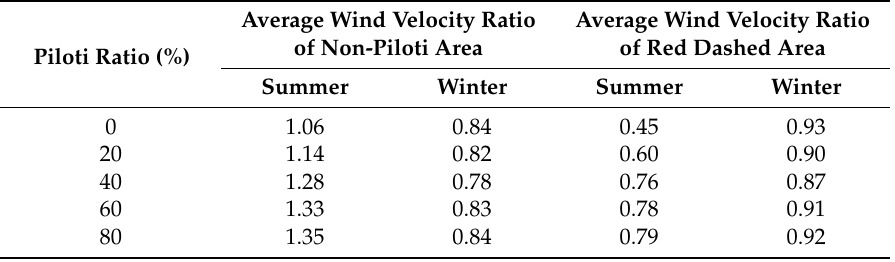
Table 9. The relationship between the piloti ratio and the average wind velocity ratio. Average Wind Velocity Ratio of Non- Piloti Ratio Piloti Area